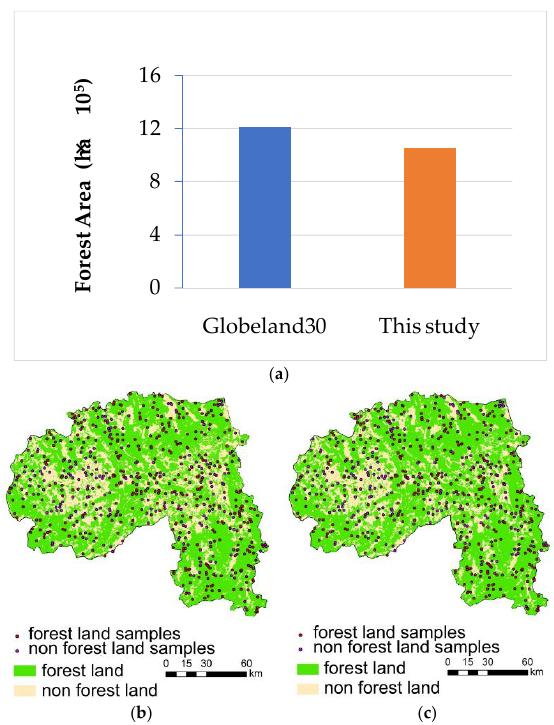
Figure 3. ( a ) Forest area in 2010 from Globeland30 and this study; ( b )spatial distribution of the validation samples in Globeland30; ( c ) spatial distribution of the validation samples in this study. The areas, changes, and dynamics of the three types of land use in 1990, 2000, and 2010 are shown in Figure 4.